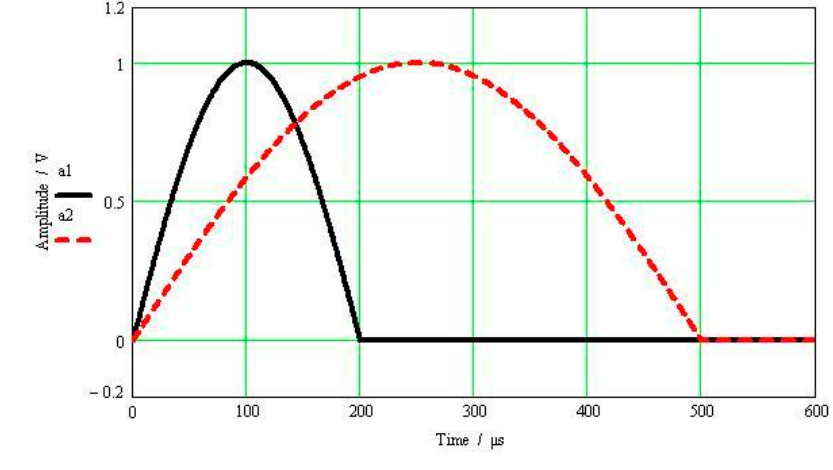
Figure 1. Half-sine excitation pulse.